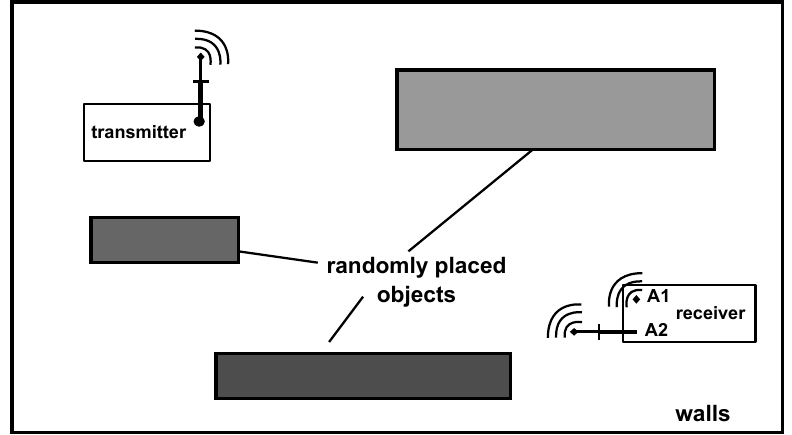
Figure 12. Multipath laboratory setup with randomly placed